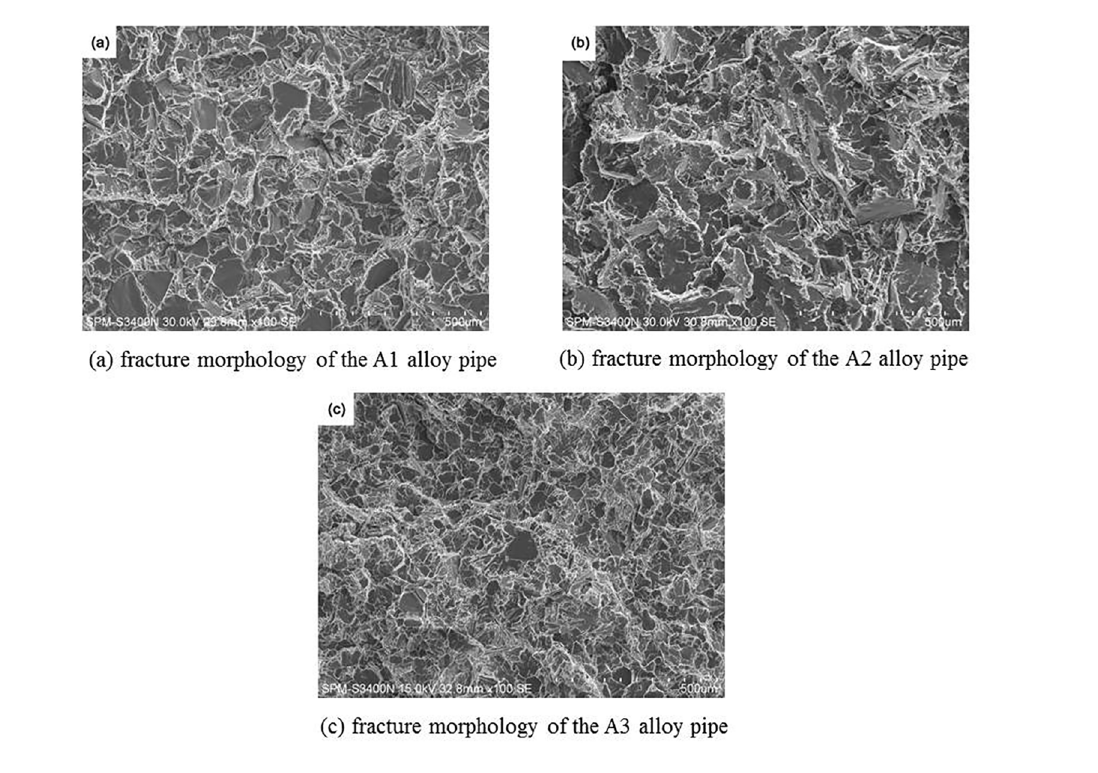
Figure 10. Fracture morphologies of the inner part of the A1, A2, and A3 alloy